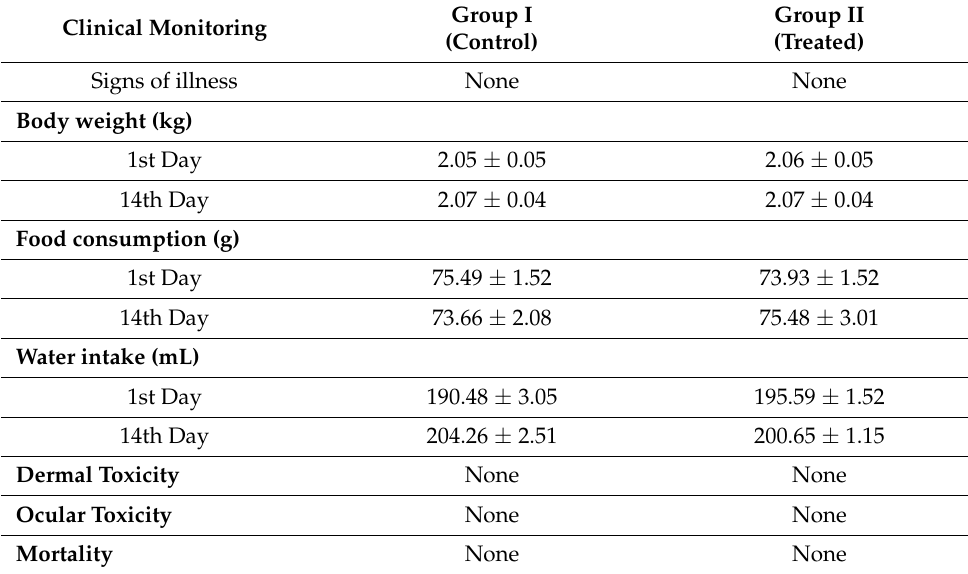
Table 3. Clinical observation data from oral toxicity studies.